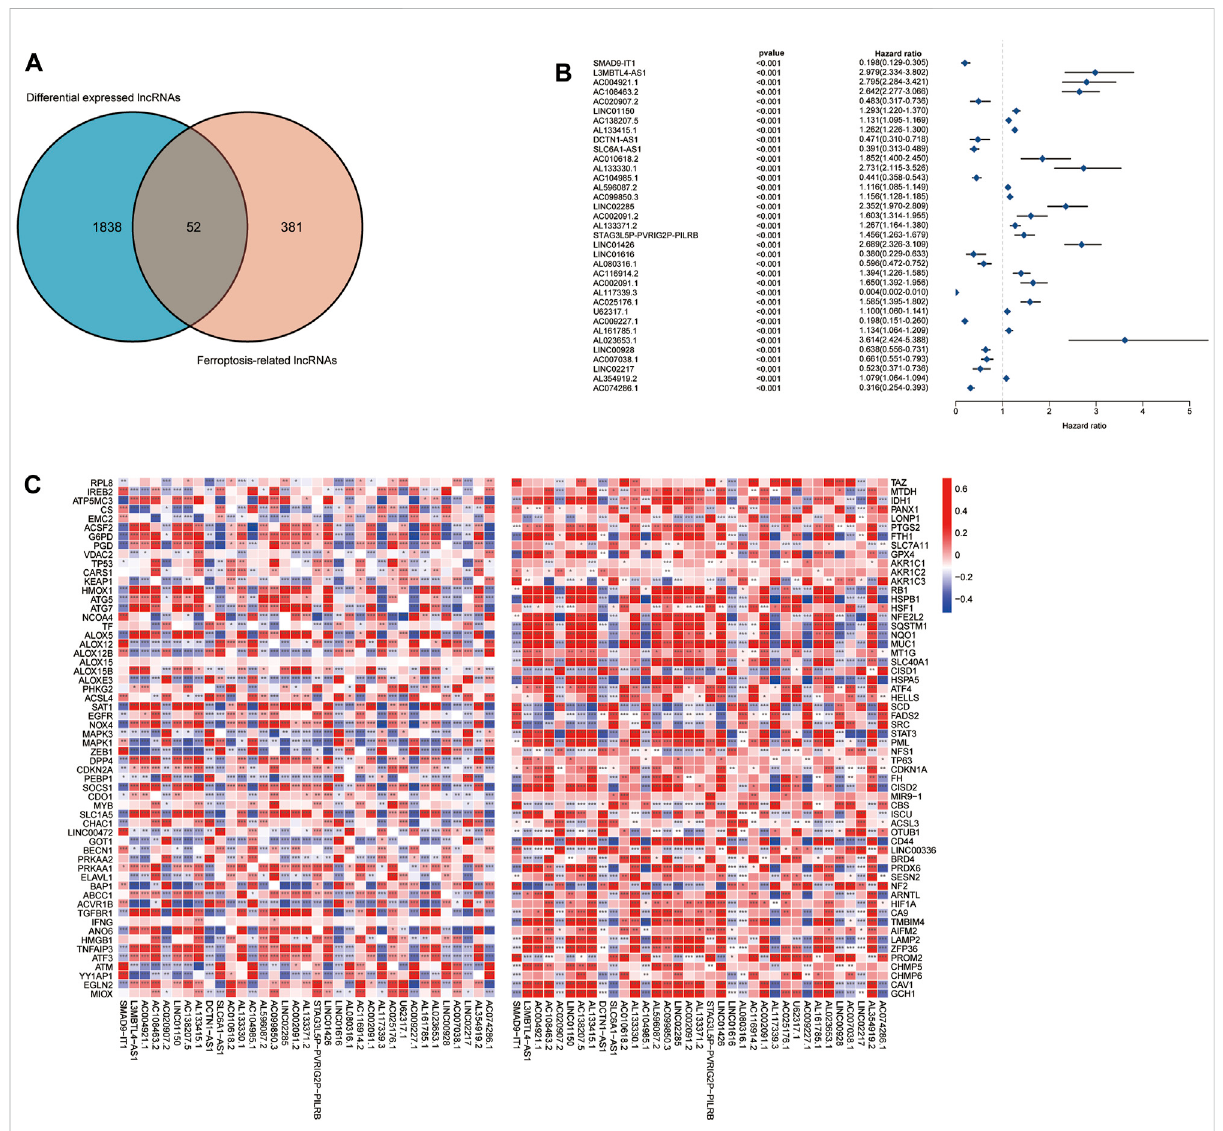
FIGURE 2 Prognostic analysis of differentially expressed ferroptosis-related lncRNAs. (A) Differentially expressed FRLs obtained from differentially expressed lncRNAs and FRLs by Venn diagram. (B) Forest plots showing the results of the Cox univariate regression analysis approximately 35prognosticdifferentiallyexpressedFRLs. (C) Thecorrelationbetween35prognosticFRLsand176FRGsintheTCGA-LGG/GBMcohort.Thecolour of each unit shows the degree of corelation. * p < 0.05, ** p < 0.01, and *** p <